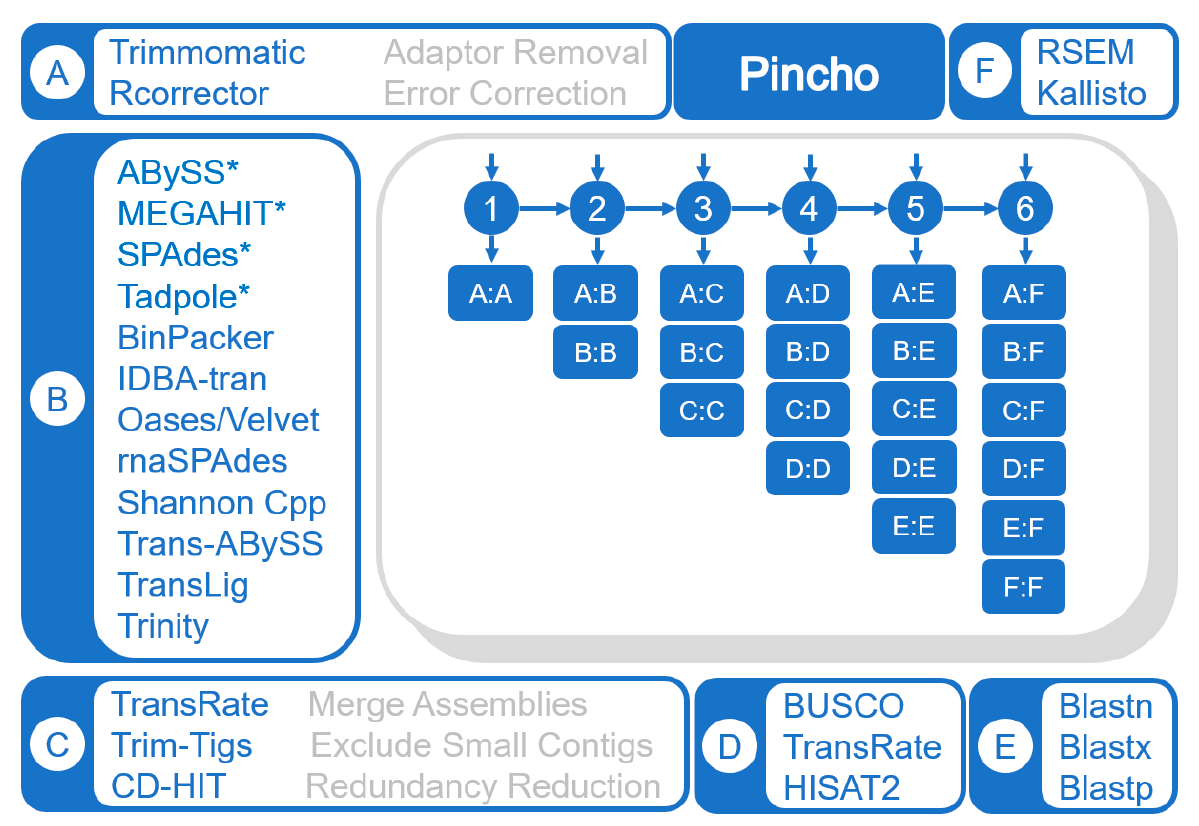
Figure 1. Pincho Management Workflow. Software installed in the Pincho workflow v0.1,